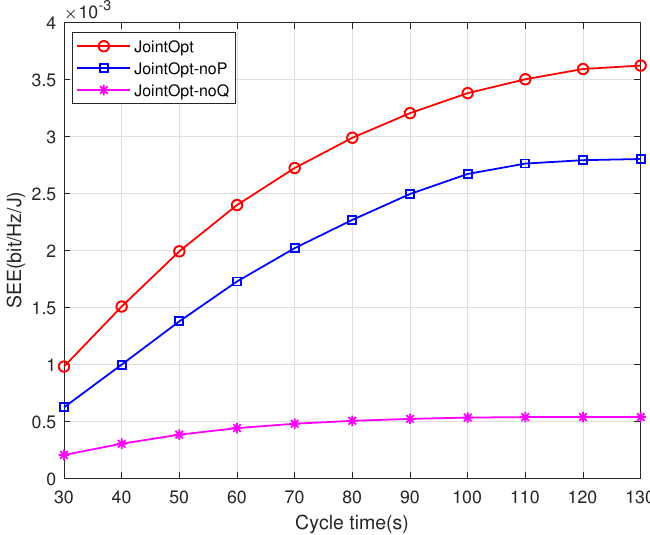
Figure 6. Comparison of system SEE performance.